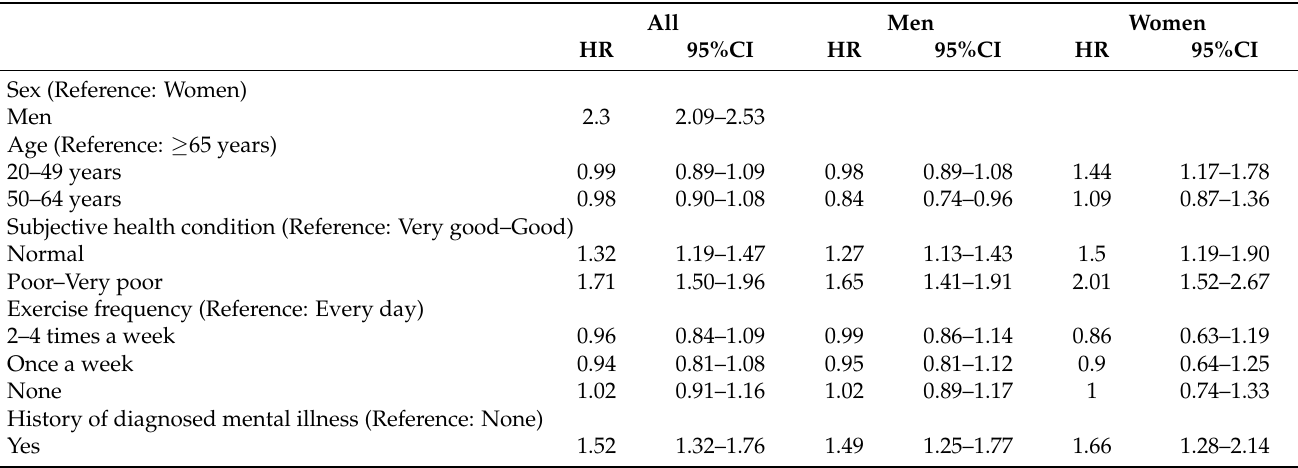
Table 2. Crude hazard ratios and 95% confidence intervals for the occurrence of problem drinking from FY 2012 to FY